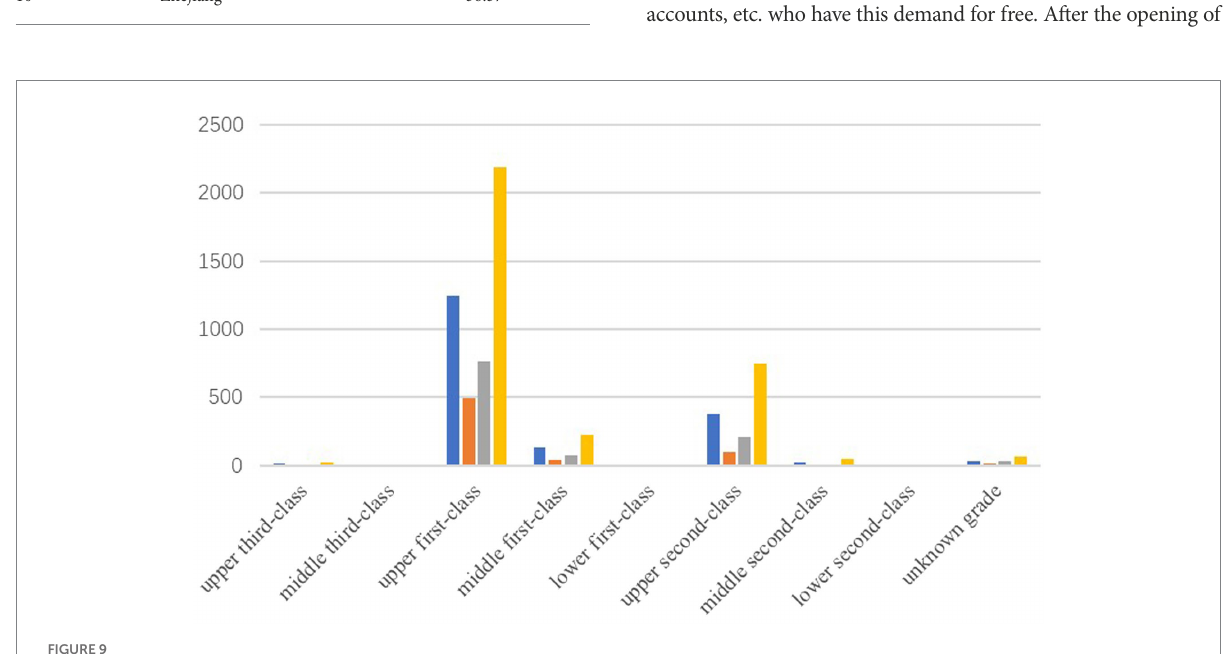
FIGURE 9 Number of online doctors at all